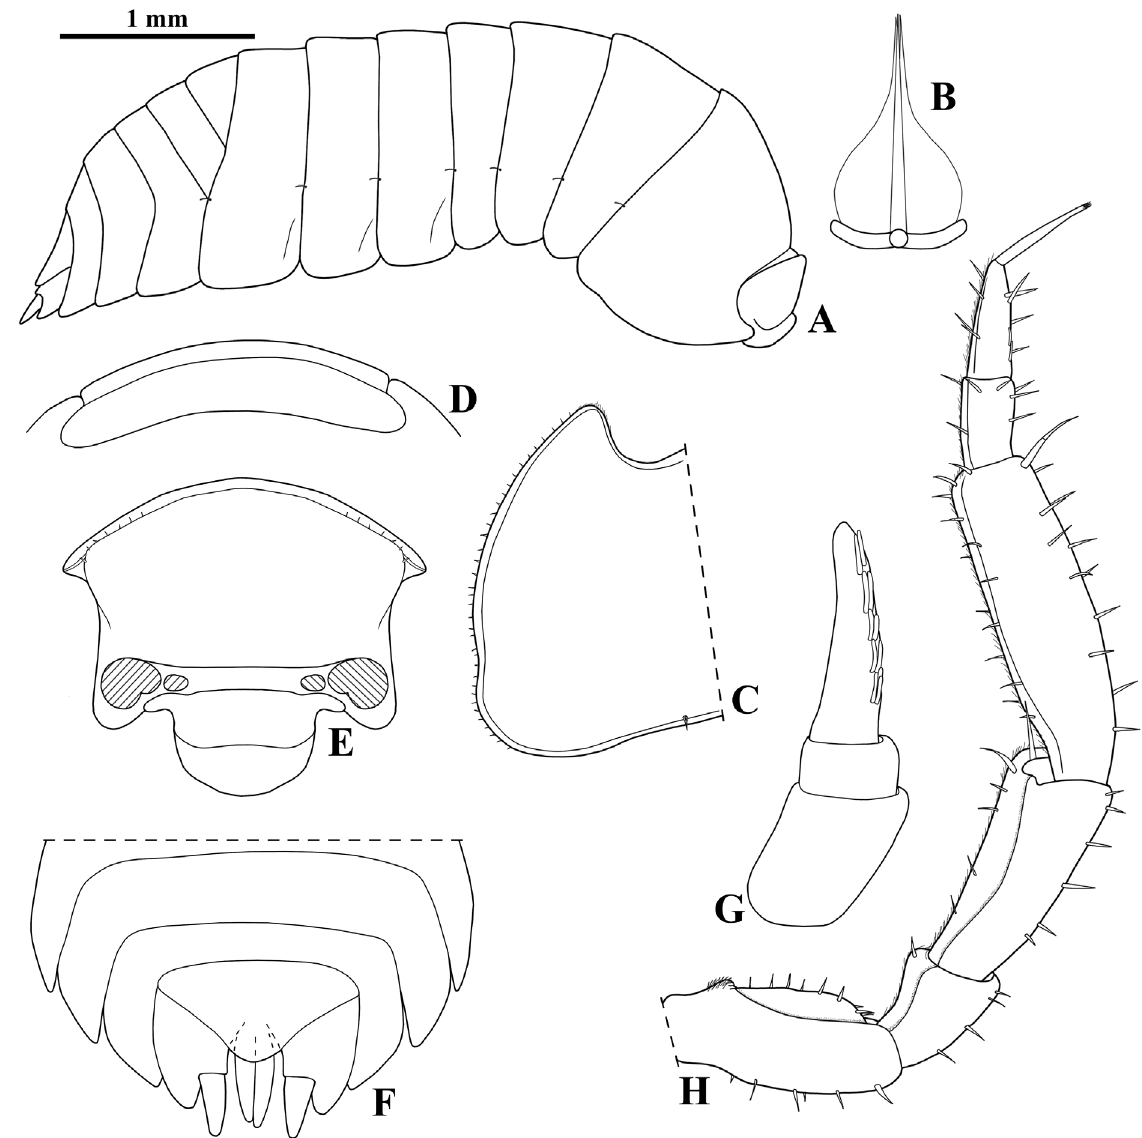
Fig. 11. Amazoniscus spica Campos-Filho, Aguiar & Taiti sp. nov., ♀, paratype (MZUSP 40047). A . Habitus, dorsal view. B . Dorsal scale-seta. C . Pereonite 1 epimeron, dorsal view. D . Cephalon and pereonite 1, back view. E . Cephalon, frontal view. F . Pleonites 3–5, telson and uropods. G . Antennula. H .